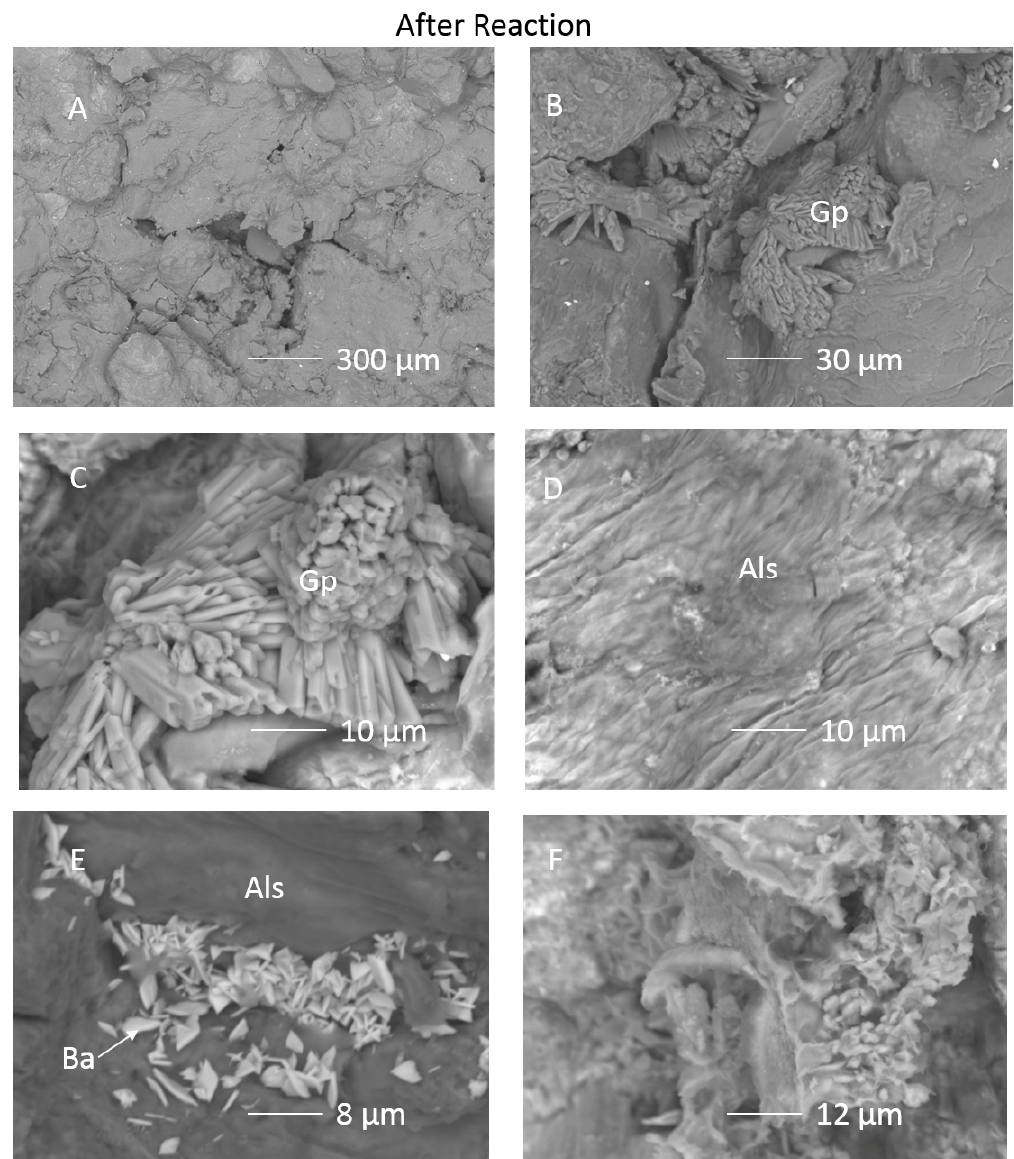
Figure 5. SEM images of the inner surface of the cap ‐ rock sub ‐ sample after reaction ( A ) surface view of a Si ‐ Al ‐ containing precipitated layer on grains; ( B ) Gypsum growing in pore space; ( C ) Gypsum crystals; ( D ) Si ‐ Al containing precipitated layer; ( E ) Barite crystals on and in Si ‐ Al ‐ precipitated layer; ( F ) Skeletal pore filling clay. Gp = gypsum/Ca ‐ sulphate, Als = precipitated aluminosilicate layer.